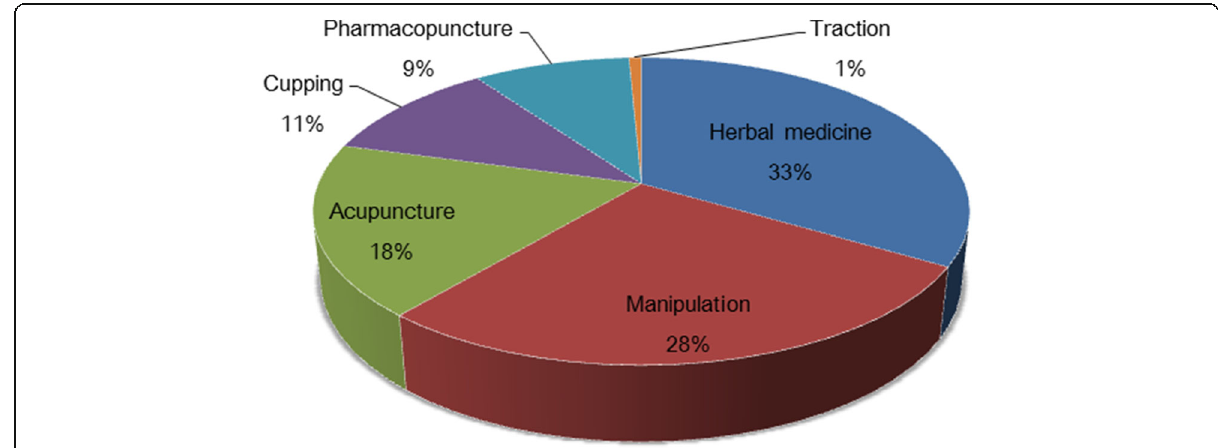
Fig. 1 Total cost of Korean medicine